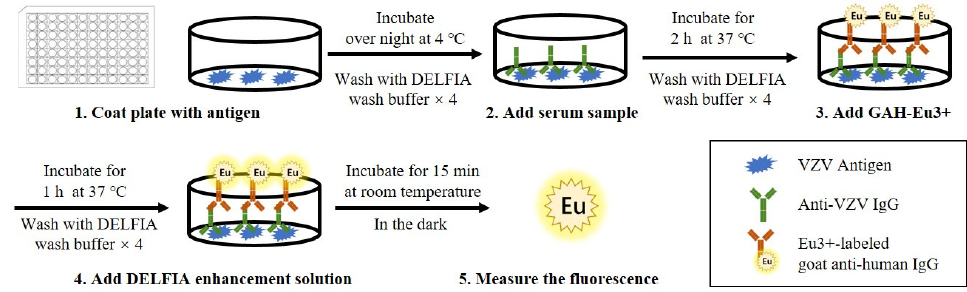
Figure 5. Schematic diagram depicting the basic steps of TRFIA for the detection of anti-VZV antibodies. (1) DELFIA microtiter plates are coated with VZV antigen and incubated overnight at 4 °C. (2) After washing, diluted serum samples are added to the plates and incubated for 2 h at 37 °C. (3) After washing, europium (Eu3+)-labeled goat anti-human IgG (GAH-Eu3+) is added and incubated for 1 h at 37 °C. (4) After washing, DELFIA enhancement solution is added and incubated for 15 min at room temperature in the dark. (5) The plate is read using a DELFIA 1234 reader to measure the fluorescence intensity of EU3+.